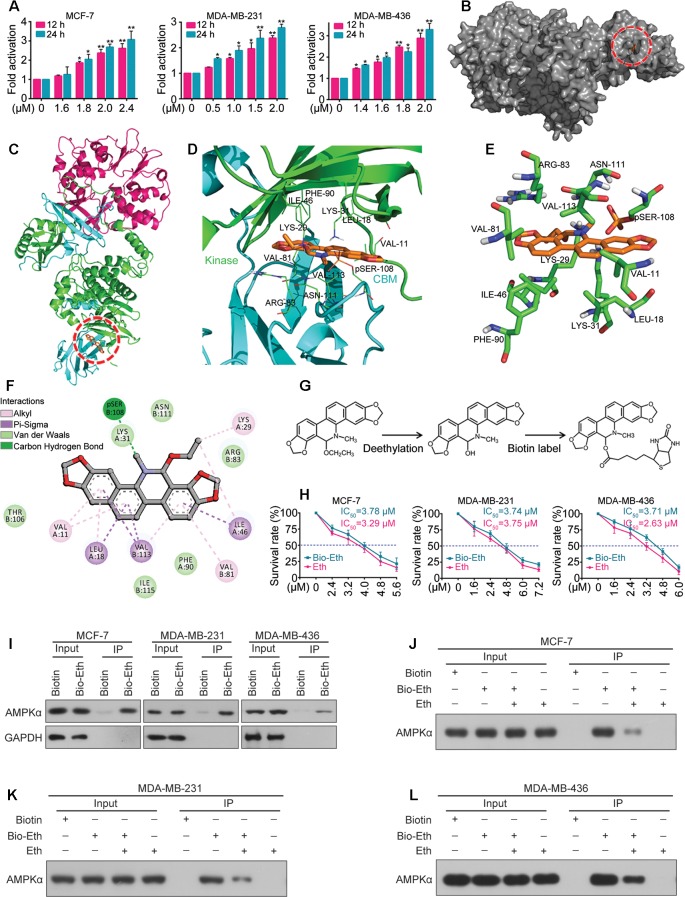
Eth is a direct activator of AMPK. (A): MCF-7, MDA-MB-231, or MDA-MB-436 cells were treated with increasing concentrations of Eth for 24 h, and AMPK activity assay was performed. (B): The binding mode of Eth docked into AMPK. (C): The binding mode of Eth docked into AMPK. α subunit is green, β subunit is cyan, γ subunit is magenta and Eth is gold. (D): Details of the binding site of Eth in the ADaM site of AMPK. The main residues involved in drug interactions are shown as labeled green sticks. α subunit is green, β subunit is cyan. The pSER-108 was shown in stick and colored by gold. (E) The interaction pattern of Eth with the residues. (F): The 2D representation of the AMPK crystal structure in complex with Eth. (G): Chemical structure of Eth intermediate and Biotin-labeled Eth. (H): Viability of MCF-7, MDA-MB-231 or MDA-MB-436 cells exposed to Biotin-Eth as determined by MTT assay. (I): MCF-7, MDA-MB-231, or MDA-MB-436 cells were treated with 4 μM Biotin or Bio-Eth for 12 h, lysed, and the cell lysates were subjected to immunoprecipitation using S. agarose and western blot using indicated antibodies. (J–L): MCF-7, MDA-MB-231, or MDA-MB-436 cells were treated with Bio-Eth (4 μM) in the presence or absence of Eth (12 μM) for 3 h, lysed, and the cell lysates were subjected to immunoprecipitation and western blot. *P < 0.05, **P < 0.01.